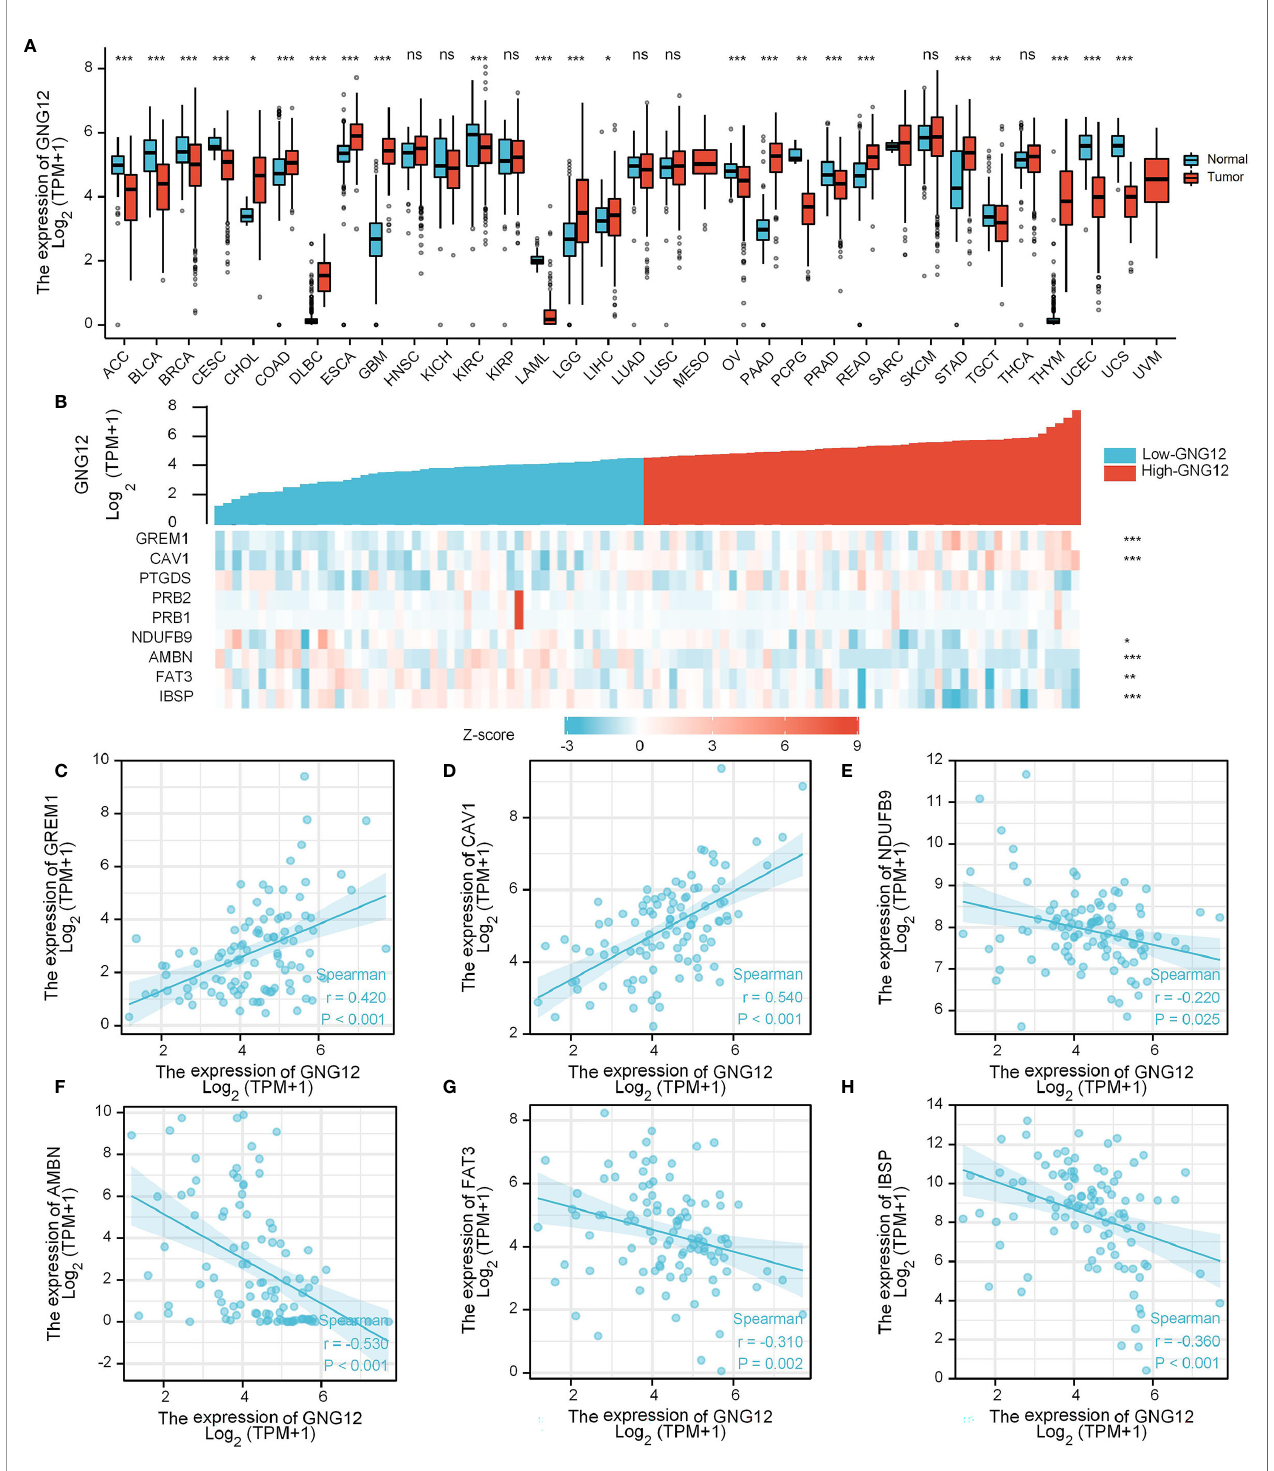
FIGURE 7 | Expression analysis of GNG12-related genes. (A) Differential expression of GNG12 in pan-cancer. (B) A gene expression-related heat map of the nine common DEGs between GEO and TARGET sets. (C – H) Scatter plots of the expression correlation between GREM1, CAV1, NDUFB9, AMBN, FAT3, and IBSP and GNG12. Signi fi cance was set at p < 0.05 (ns, p < 0.05; *p < 0.05; **p < 0.01; ***p <